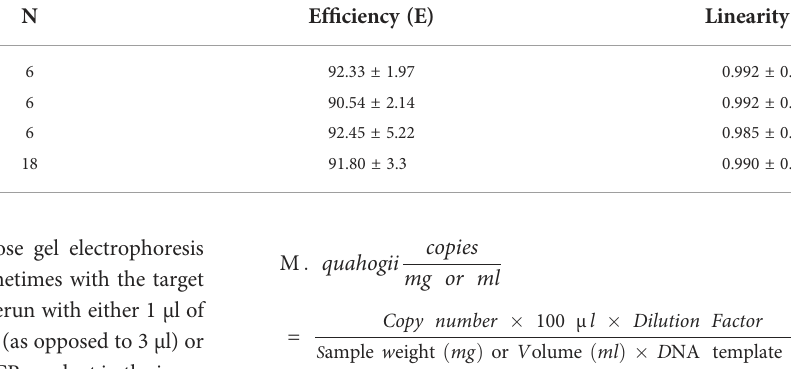
TABLE 2 Mean ± standard deviation (SD) of PCR ef fi ciency (E) and linearity (R 2 ) of spiked sample serial dilutions for inhibition testing by sample type from a mix of representative samples. Sample